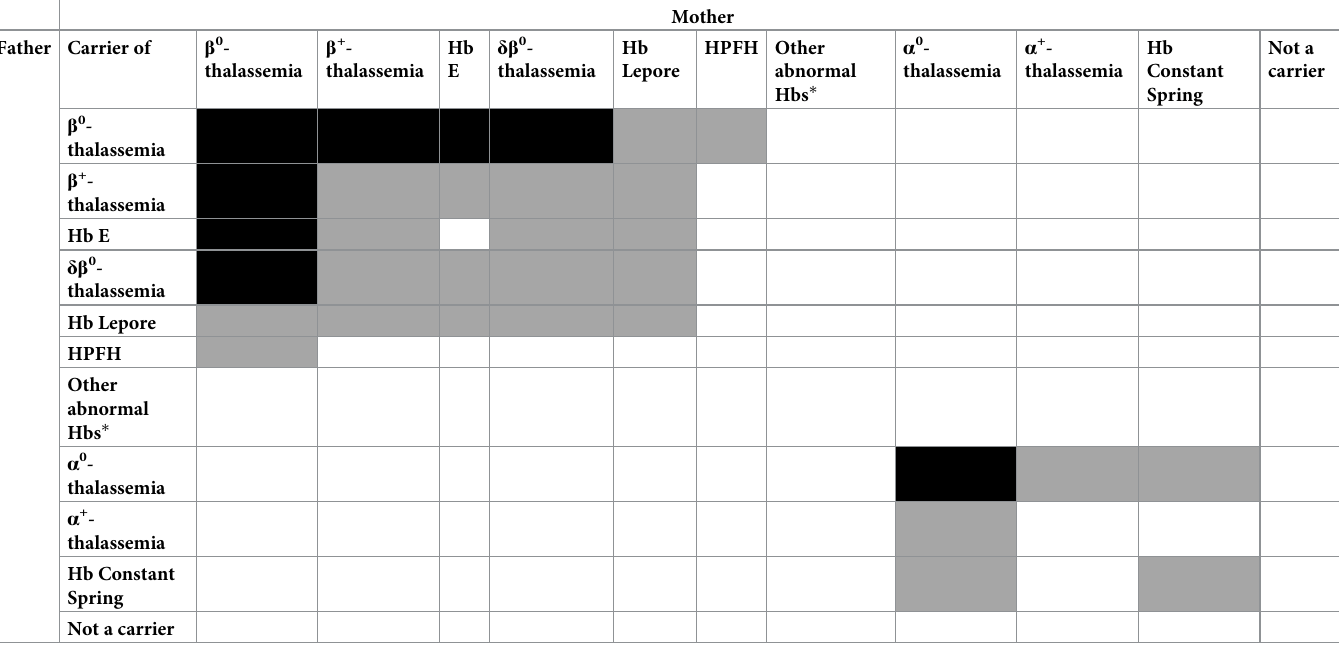
Table 1. Parental carrier state combinations that give rise to the fetal risk of having severe thalassemia (serious risk) requiring PND, less serious risk and minimal risk with no need for PND encountered in this study.